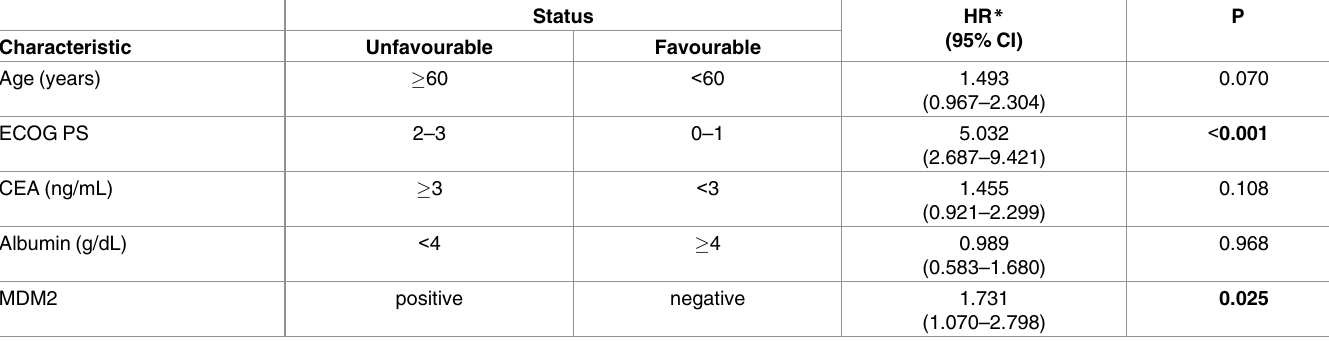
Table 3. Multivariate analysis for OS.